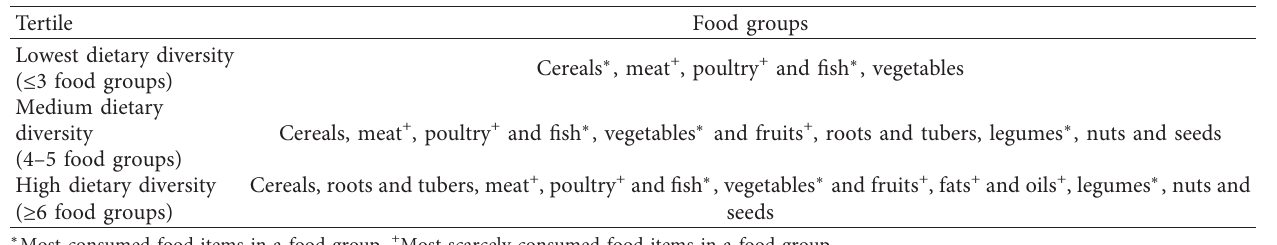
Cereals ∗ , meat + , poultry + and fish ∗ , vegetables